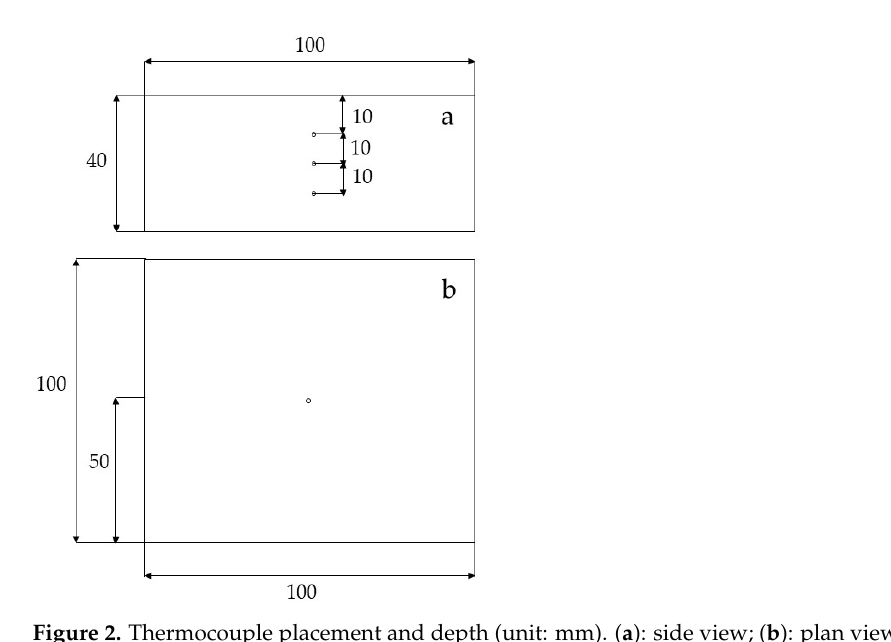
Figure 2. Thermocouple placement and depth (unit: mm). ( a ): side view; ( b ): plan view